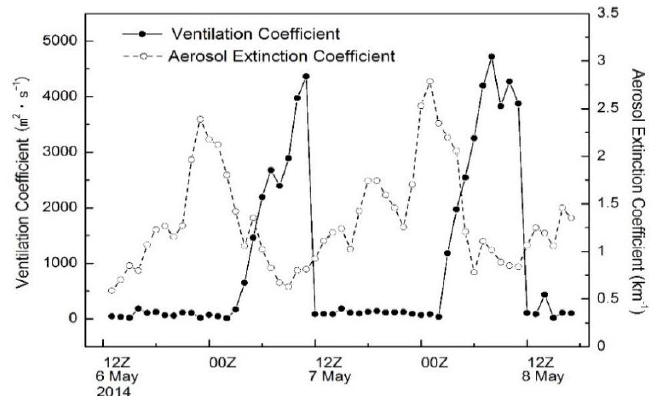
Figure 8. Hourly change in the AEC and 𝑉 𝐻 over Chengdu during the pollution event (notes: the volume fraction of pollutants was the simulation result obtained based on the mesh closest to the comprehensive substation at the Chengdu University of Information Technology).